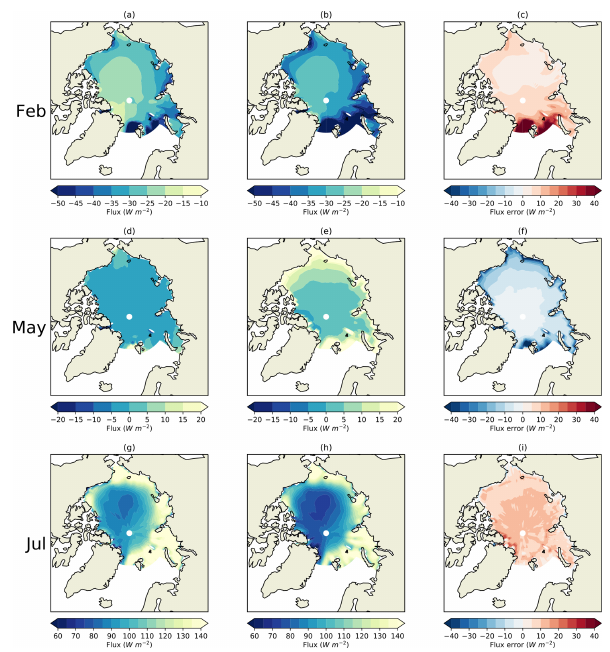
Figure B1. Illustrating approximated (left) and actual (centre) model net surface flux, as well as the approximation error (right), in (a) – (c) February; (d) – (f) May; (g) – (i) July, for the period 1980– 1999 in the first historical run of HadGEM2-ES.